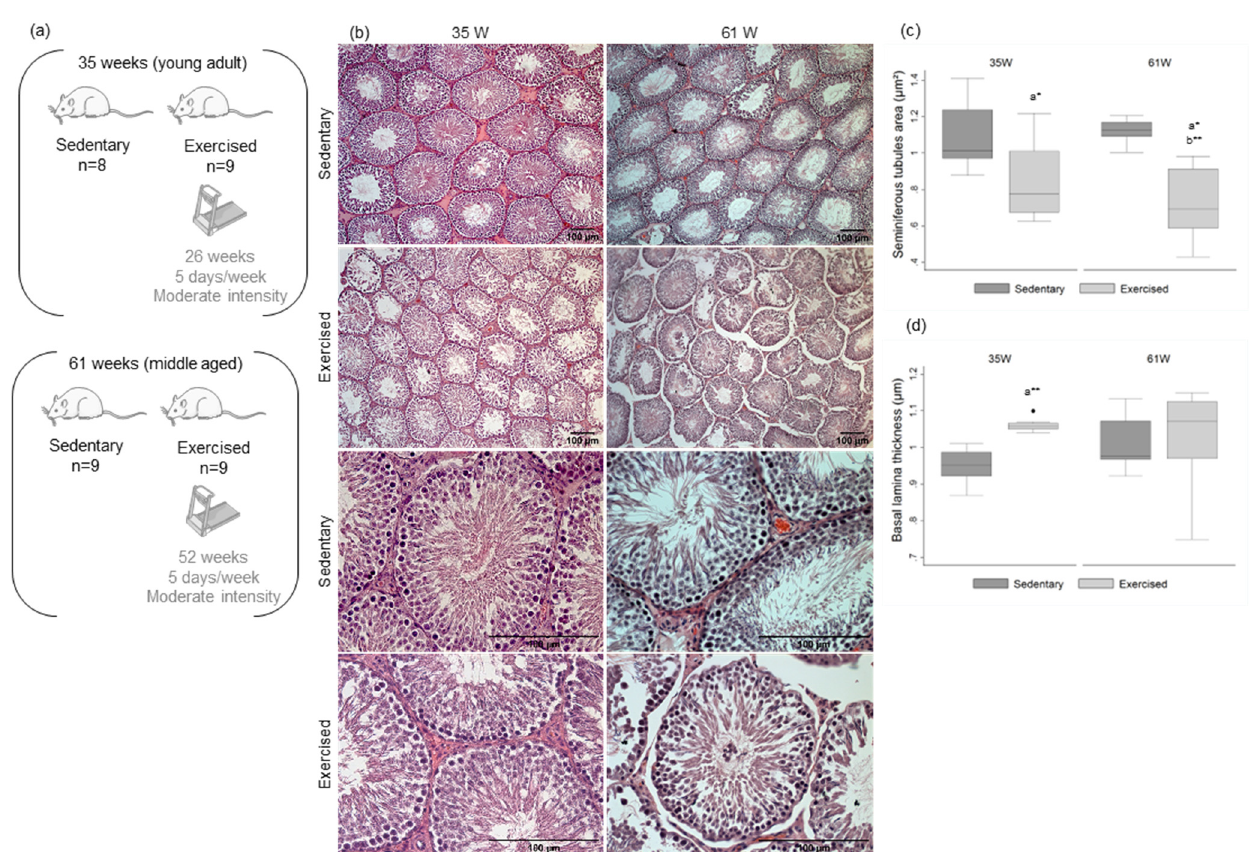
Figure 1. Experimental groups and effect of age and exercise training on rats’ testicular morphology. ( a ) Experimental groups. ( b ) Representative H&E stains of histological morphology of rat testes of the four experimental groups (upper panels, ×100 amplification; lower panels, ×400 amplification). ( c , d ) Box and whisker plots show the ( c ) area of seminiferous tubules and ( d ) basal lamina thickness of the four experimental groups. The horizontal line displays the median, the box edges show the 25th and 75th percentiles and the whiskers show the smallest and highest value within 1.5 box lengths from the box. ( n = 8 for 35 W Sedentary; n = 9 for 35 W Exercised, 61 W Sedentary and 61 W Exercised). * p < 0.05; ** p < 0.01. a—Significantly different from 35 W Sedentary; b—significantly different from 61 W Sedentary.